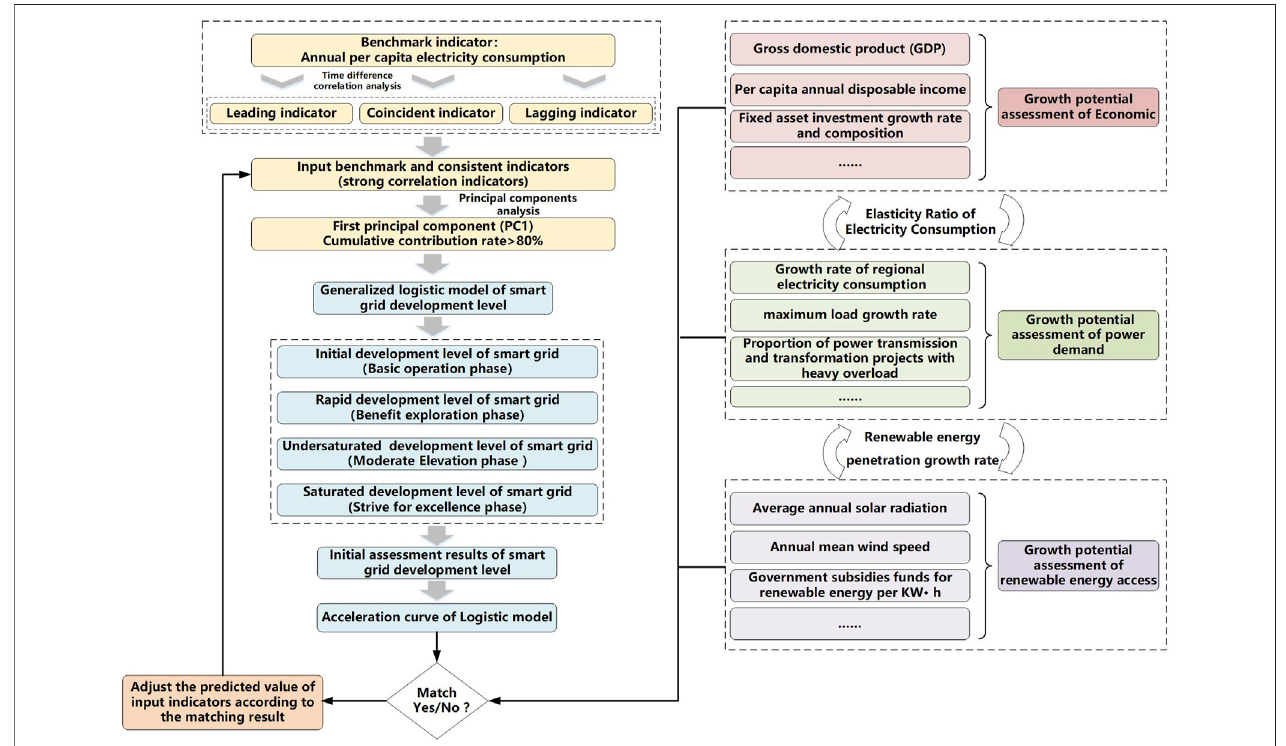
FIGURE 1 | The multi-closed-loop assessment mechanism for the development level of smart